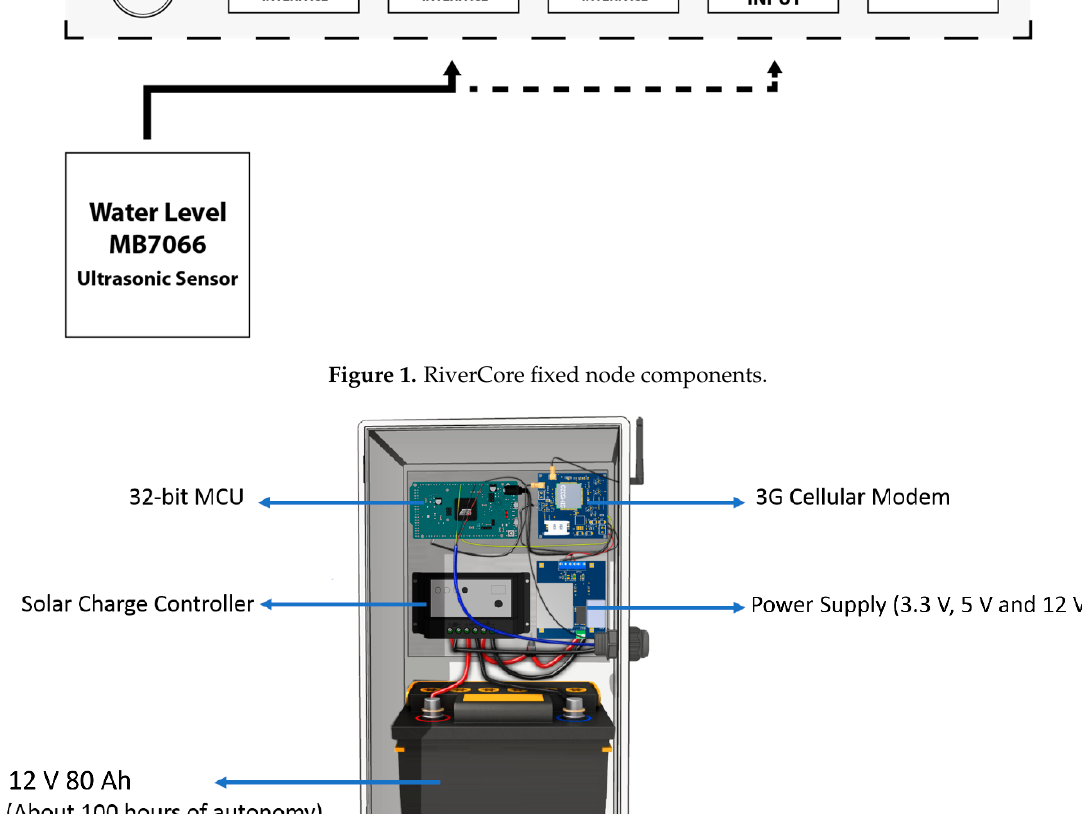
Figure 2. 3D model of a RiverCore fixed node.